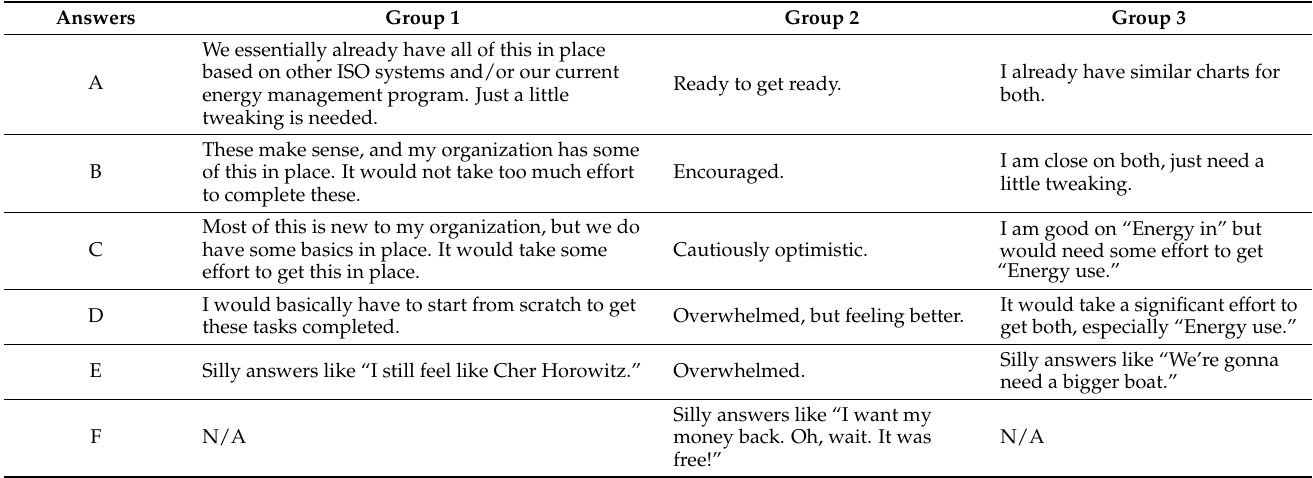
Table 4. Example answers for polling questions of Groups 1–3 (source: author’s development).